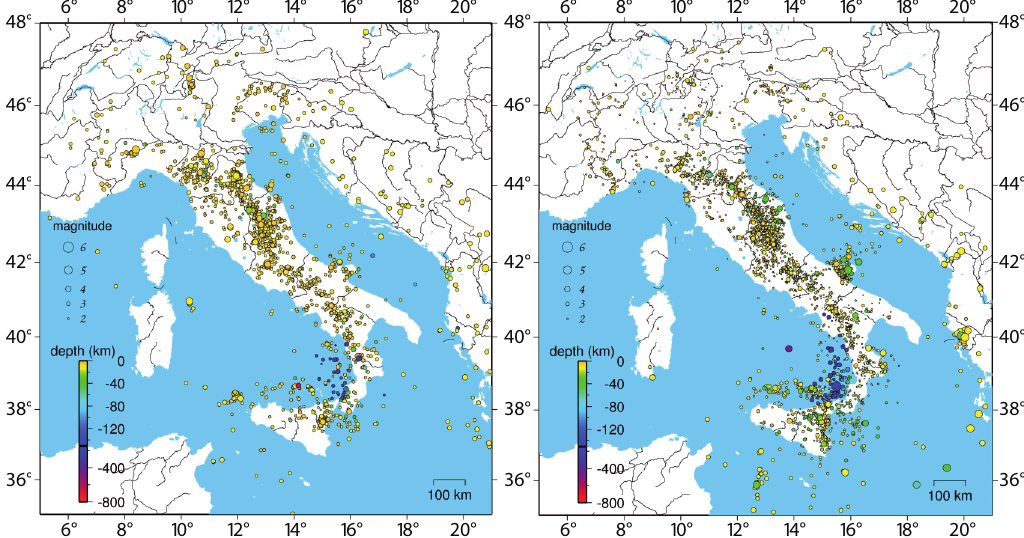
Fig. 3. Epicentral maps of Italian seismicity in 2000 (a) and 2006 (b). The number of epicenters plotted is more than 6,000 in 2006 and about 3,000 in 2000. Data are from the INGV